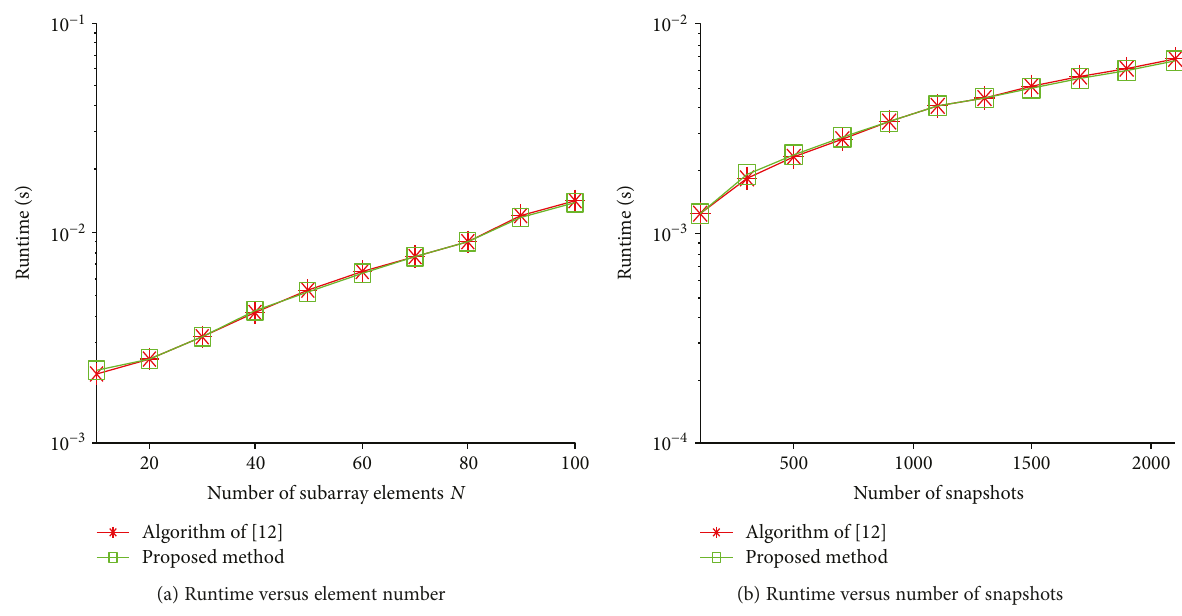
Figure 5: Runtime comparison of two